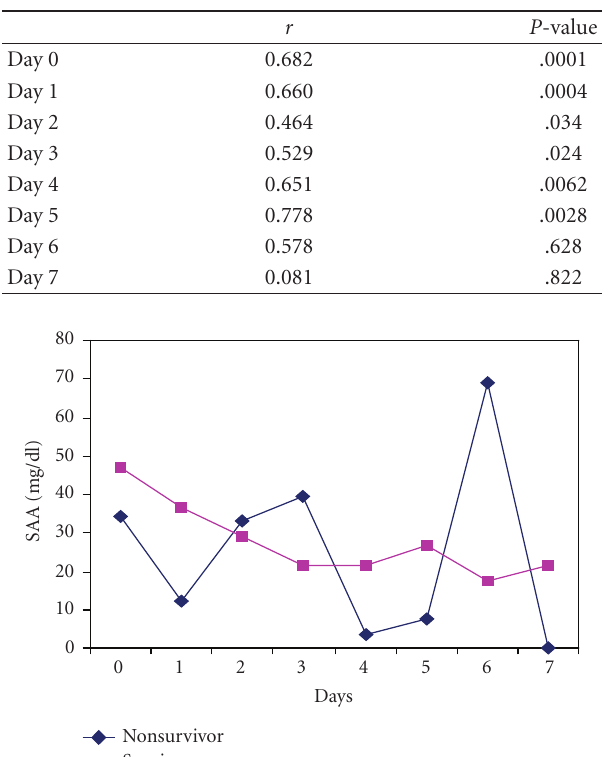
Table 4: Pearson coe ffi cient for SAA and CPR.